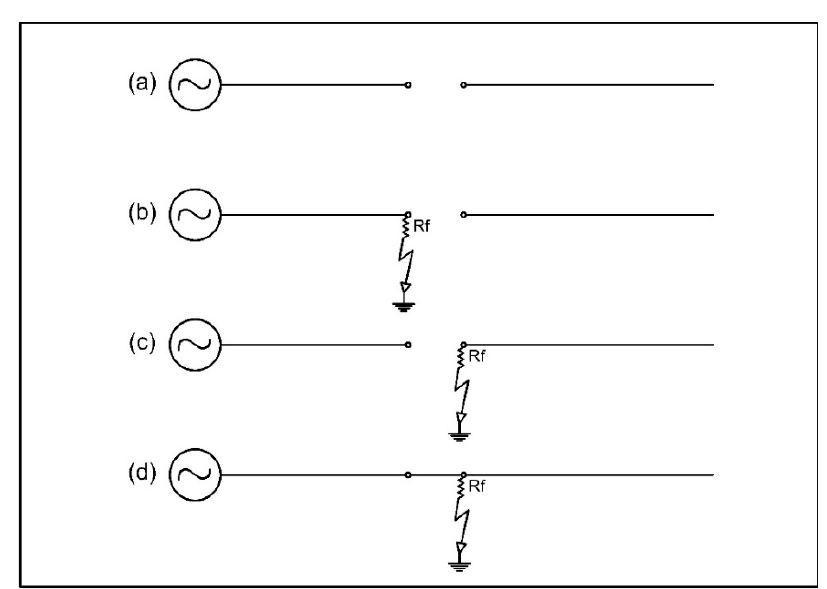
Figure 1. High impedance faults (HIF) types: ( a ) Passive series fault; ( b ) downed conductor, contact to